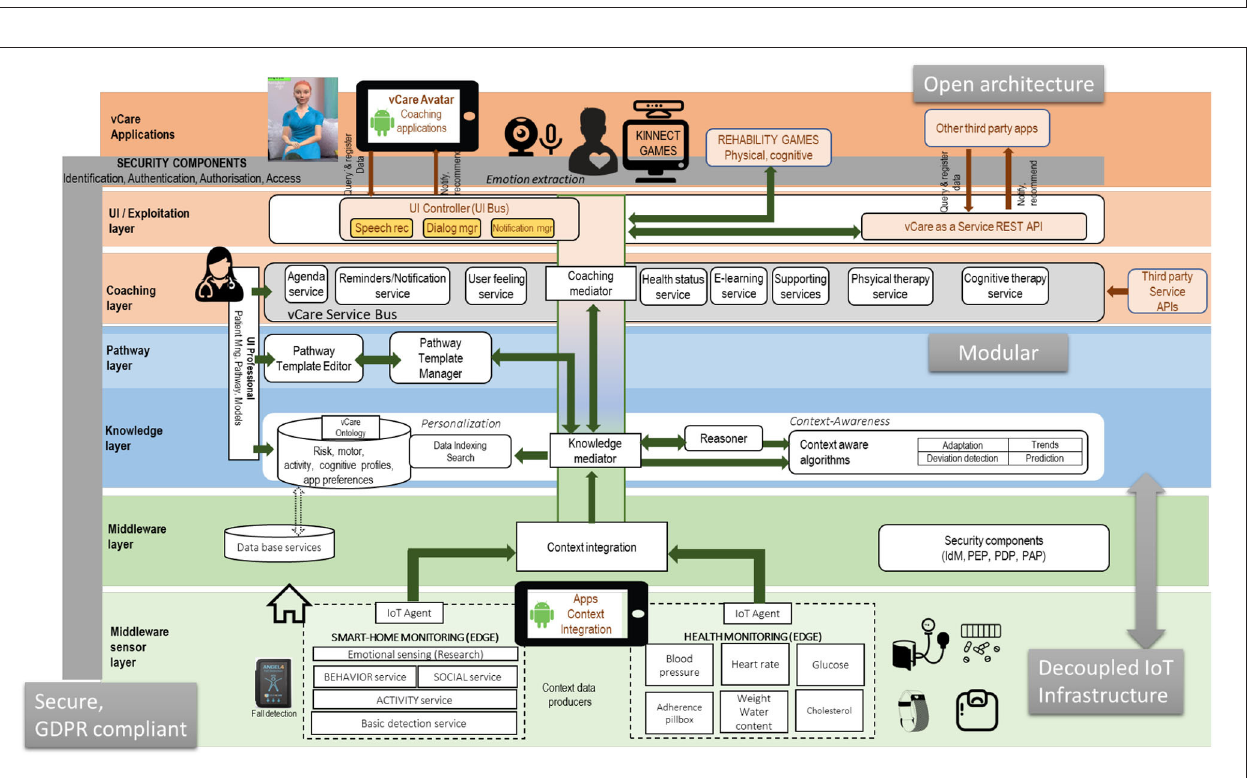
FIGURE 6 | vCare system layered